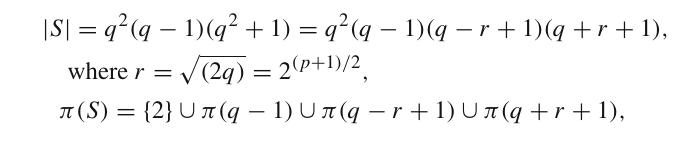
Table 7 The π -submaximal subgroups of S = Sz ( q ) , where q = 2 p , p is an odd prime. Case: 2 / ∈ π .